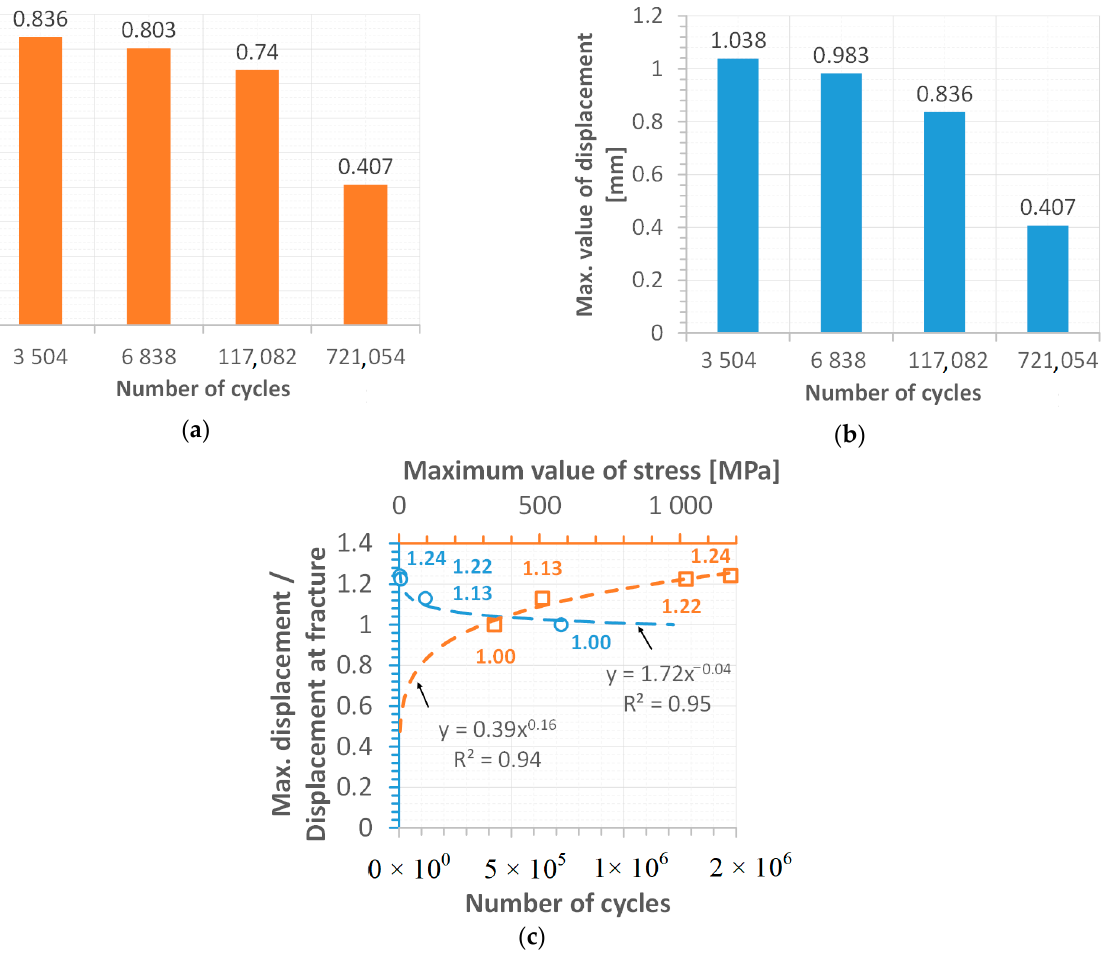
Figure 13. Variations of displacement ( a ), ( b ) its proportion versus the number of cycles and ( c ) maximum value of the stress.